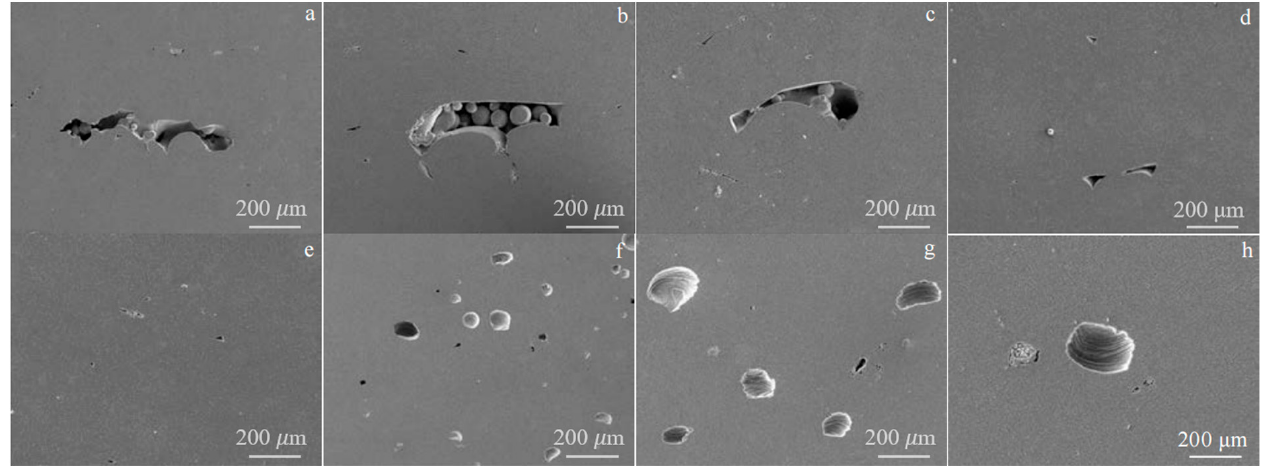
Figure 4. Diagram for defects evolution with laser energy density of 27 J/mm 3 ( a ), 33 J/mm 3 ( b ), 44 J/mm 3 ( c ), 58 J/mm 3 ( d ), 98 J/mm 3 ( e ), 213 J/mm 3 ( f ), 253 J/mm 3 ( g ) and 333 J/mm 3 ( h ). Reprinted with permission from Ref. [71]. Copyright 2021,copyright Zhao C, Li W, Wang Q, Wang Y, Zhao Y, Di S, Ren D, Ji H.